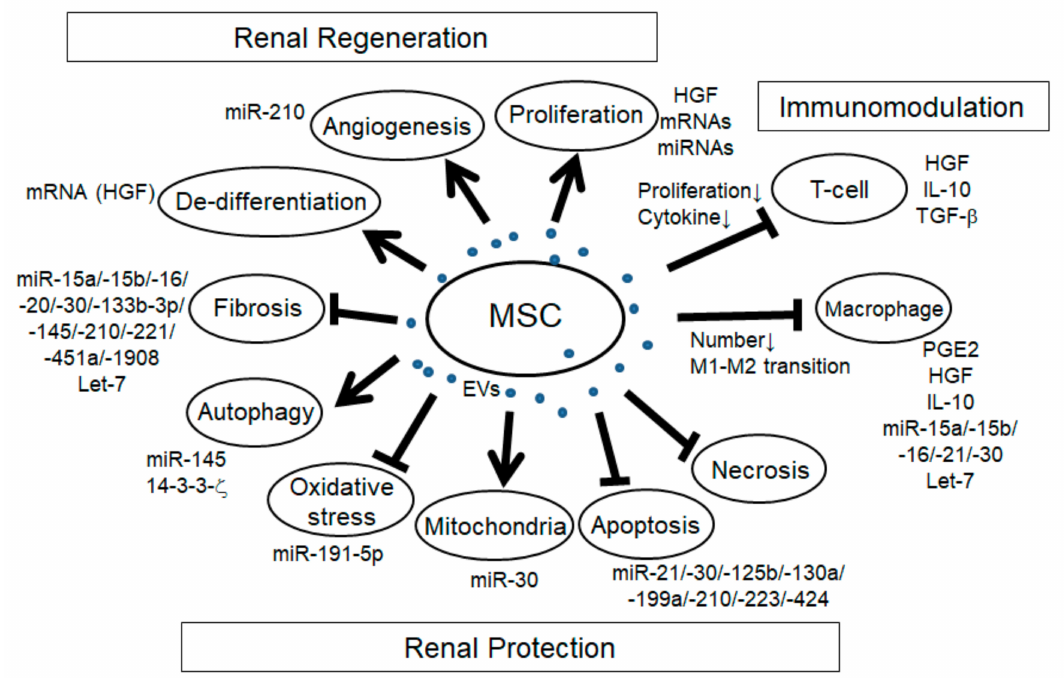
Figure 1. Schema of the e ff ects of mesenchymal stem cell extracellular vesicles (MSC-EVs) in renal injury. Arrows: promotion of the processes; T-bars: inhibition of the